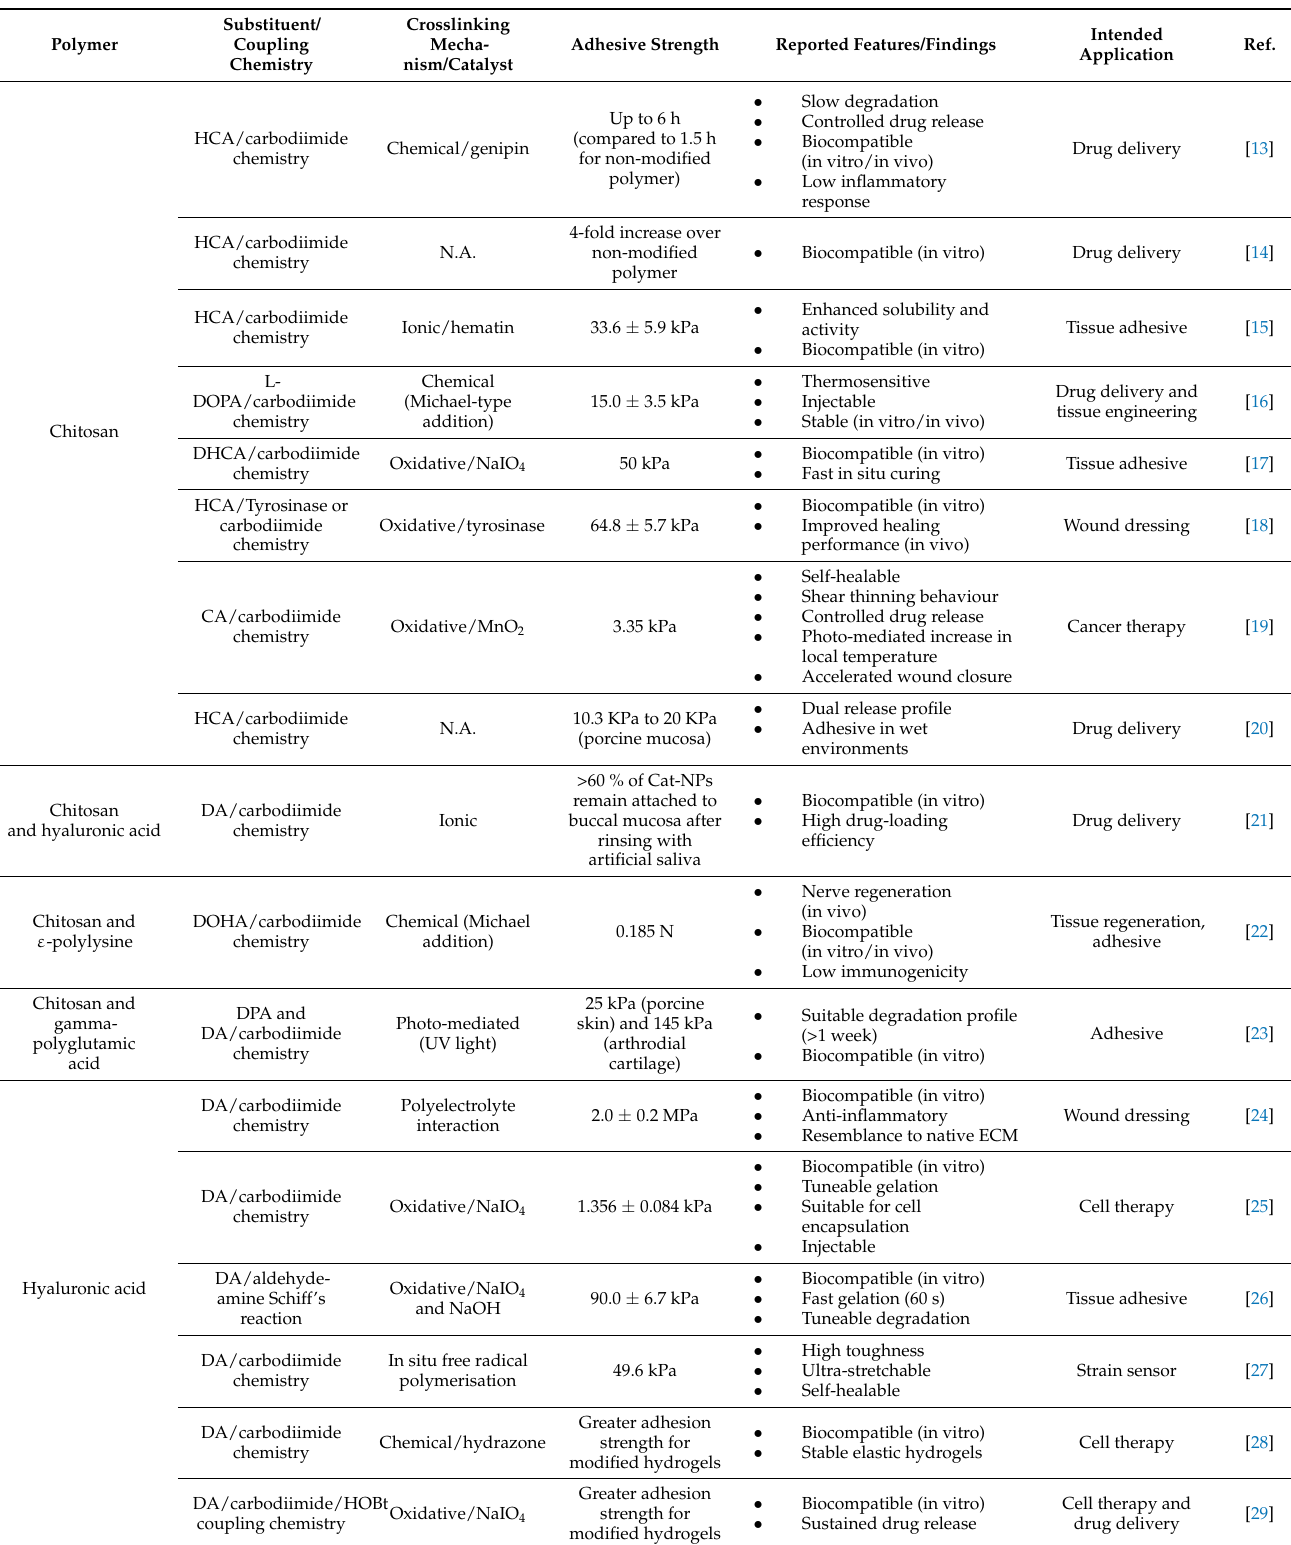
Table 3. Studies involving naturally sourced polymers, selected for